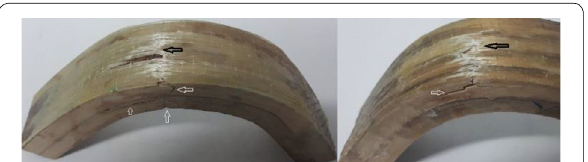
Fig. 7 Failure locations occurred in the wooden grain (white arrows) and GFRP (black arrows)